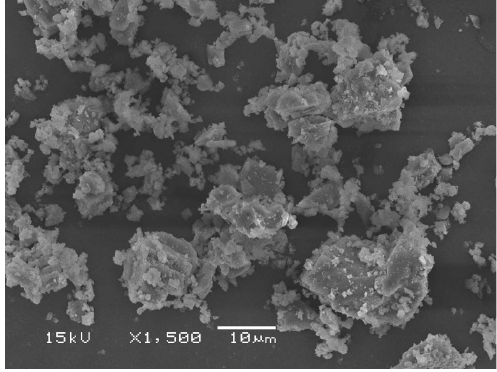
Figure 1. SEM image of CaCO 3 powder.